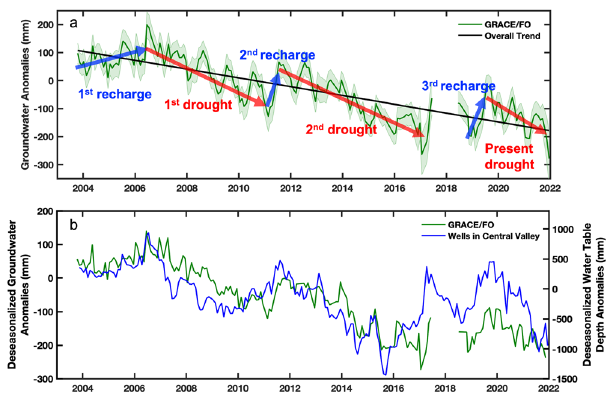
Fig. 3| GroundwaterstoragevariationsinCalifornia ’ sCentralValley.a GRACE/ FO-derived groundwater storage anomalies from September 2003 – December 2021 in the Central Valley. The green shaded margin is the uncertainty of groundwater storage. Red arrows represent groundwater loss trends during the droughts of 2006 – 2011, 2011 – 2017, and since 2019. Blue arrows represent the three short recharge periods. The black line shows the groundwater depletion trend from 2003 – 2021. b comparison of deseasonalized anomalies of GRACE/FO derived groundwater and water table depth anomalies from monitoring wells in the Central